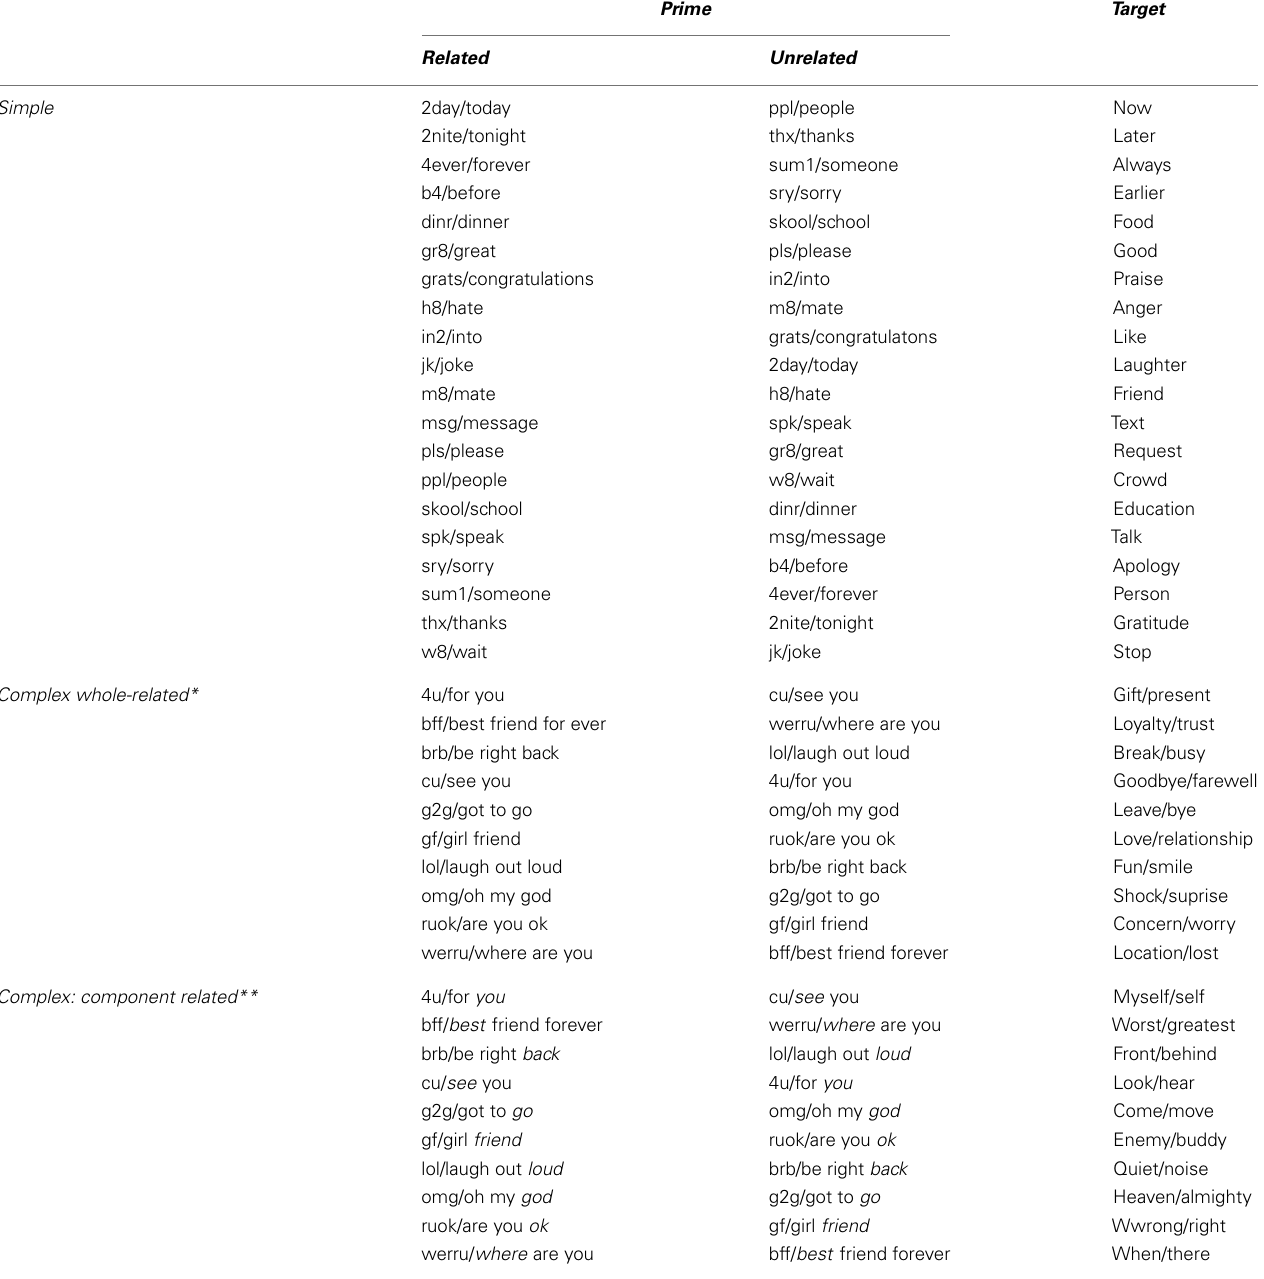
TableA1 | Related and unrelated word and shortcut prime-target